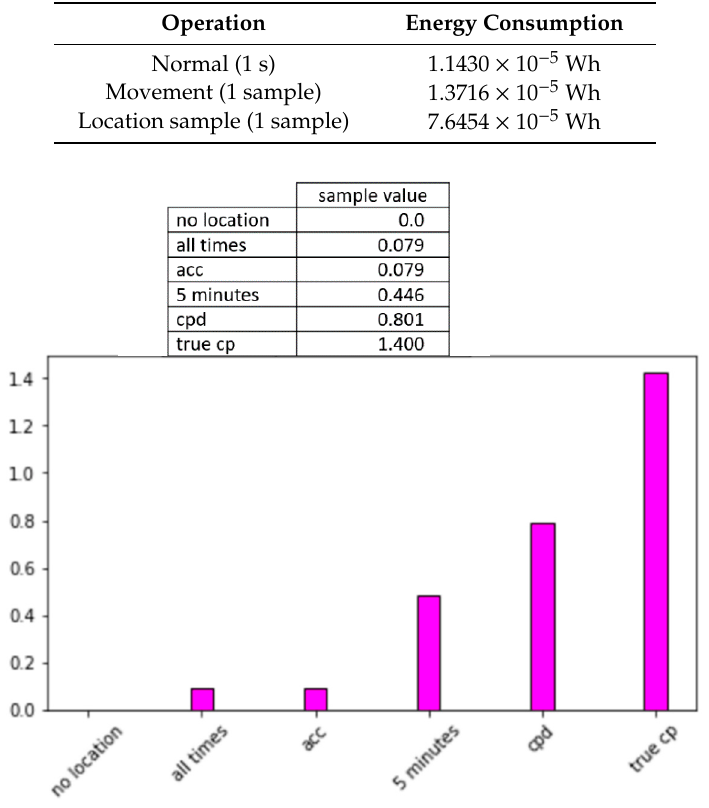
Figure 13. Comparison of value per sample between the no location, continuous location, acceleration-based location, every 5 min location, change point location (CPAM), and true change point location sampling strategies.